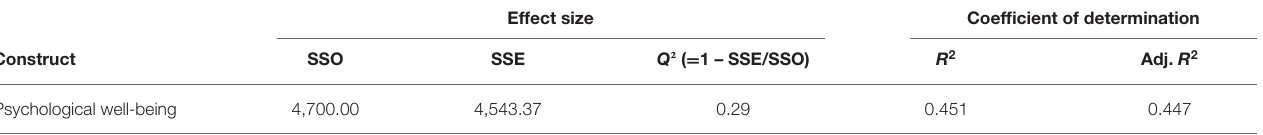
TABLE 6 | Strength of the model (Predictive relevance, coefficient of determination, and model fit indices).